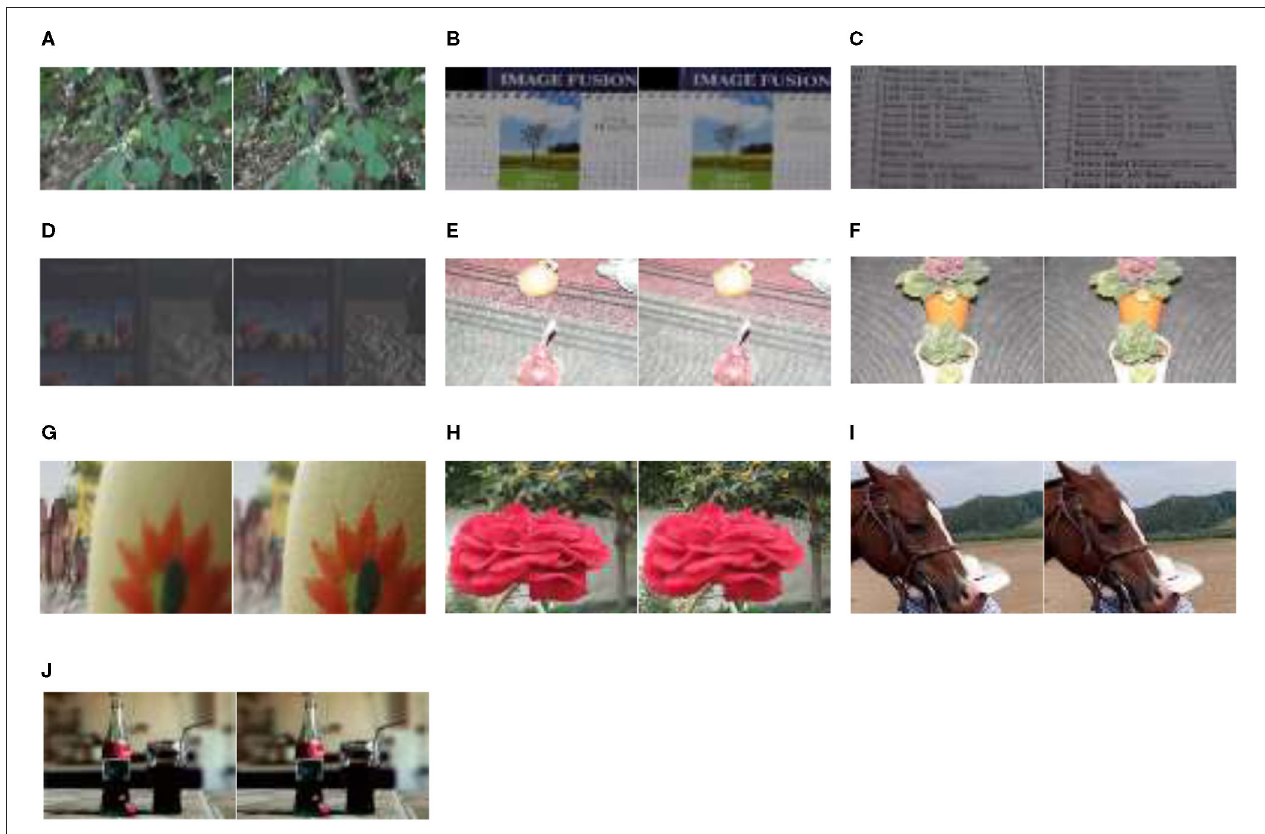
FIGURE 6 | Ten groups of multi-focus color images. (A) Size of 267 size of 320 200, (G) size of 267 × images (G,H) from Saeedi dataset, the image (I) from Lytro dataset and the image (J) from Bavirisetti